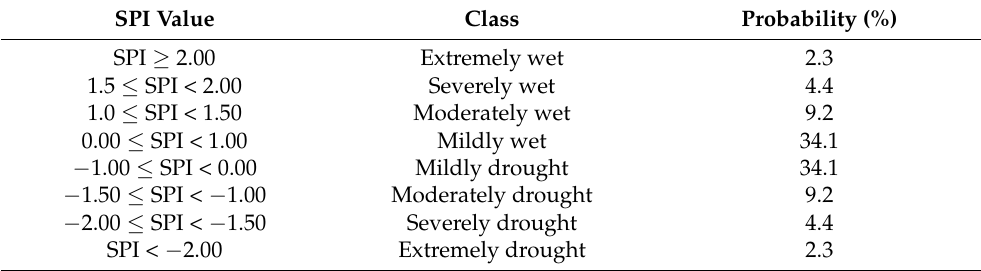
Table 1. Climate classification according to SPI